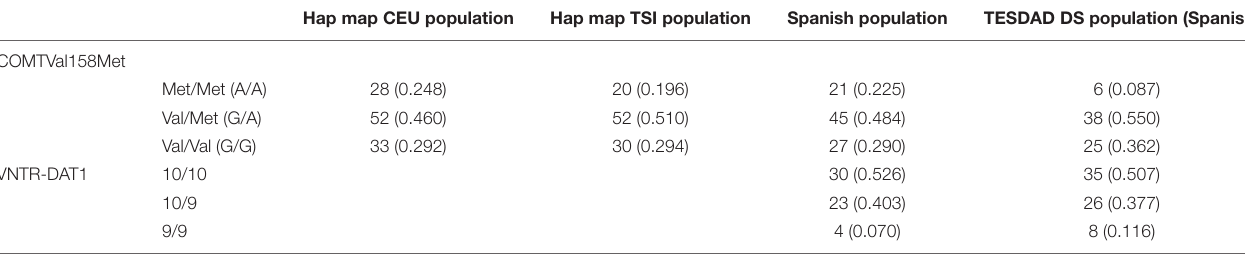
TABLE 1 | Distribution of COMTVal158Met and VNTR-DAT1 allele frequencies in the DS and reference populations. Hap map CEU population Hap map TSI population Spanish population